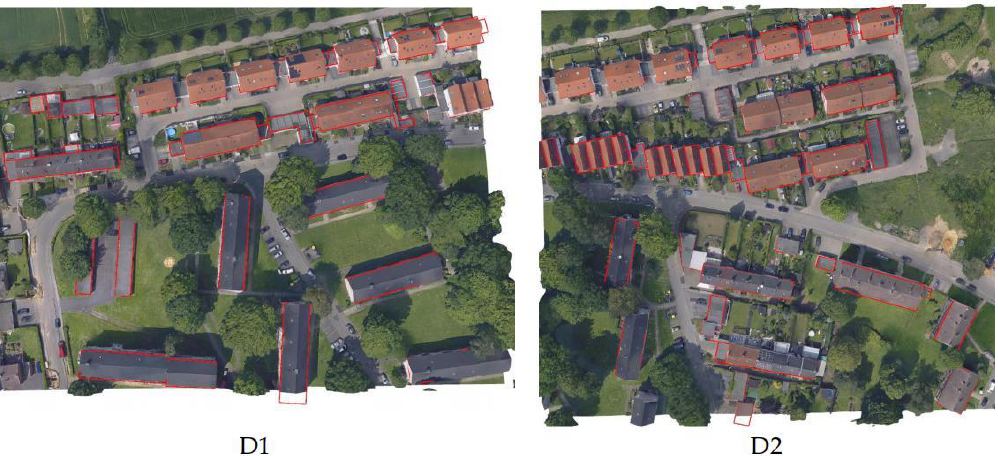
Figure 8. Two tiles of the photogrammetric point cloud and corresponding buildings footprint data (red polygons) in Dortmund.